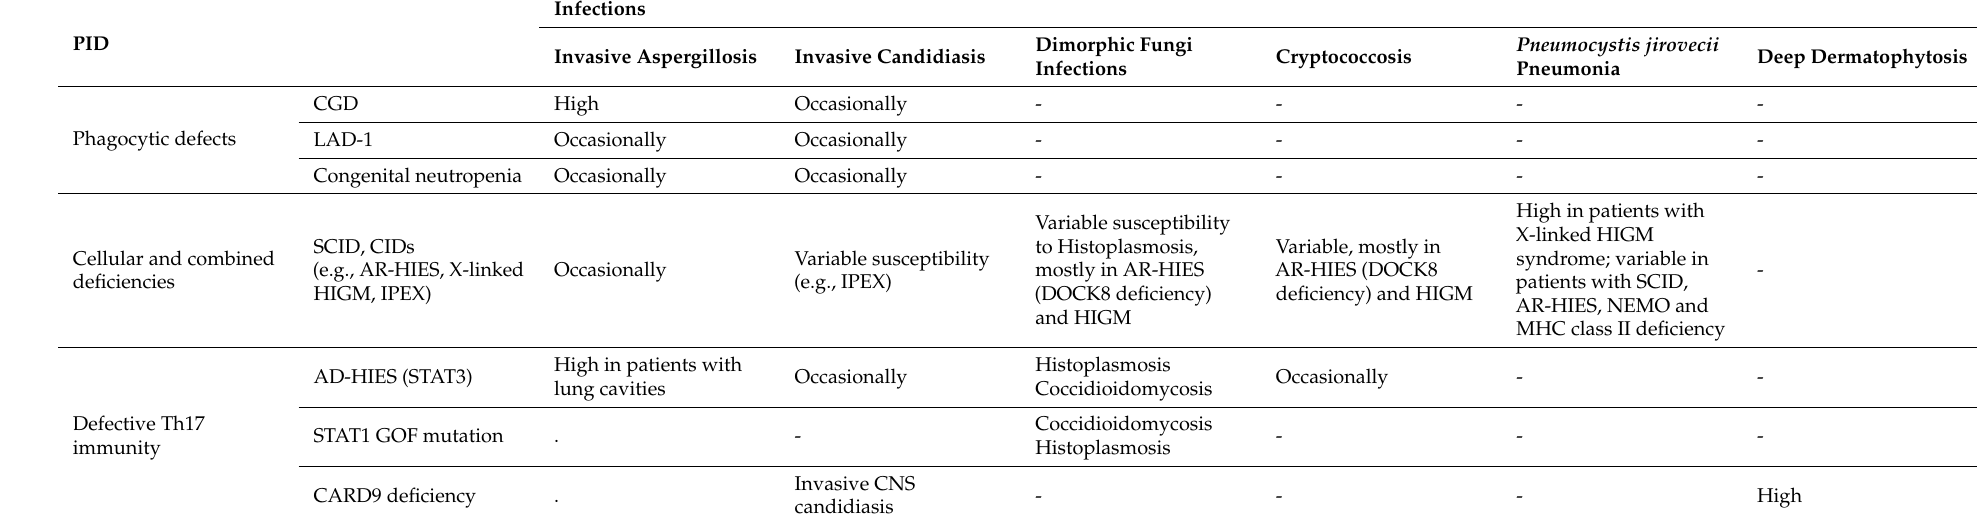
Table 4. Primary immunodeficiencies (PID) and invasive fungal disease (adapted from